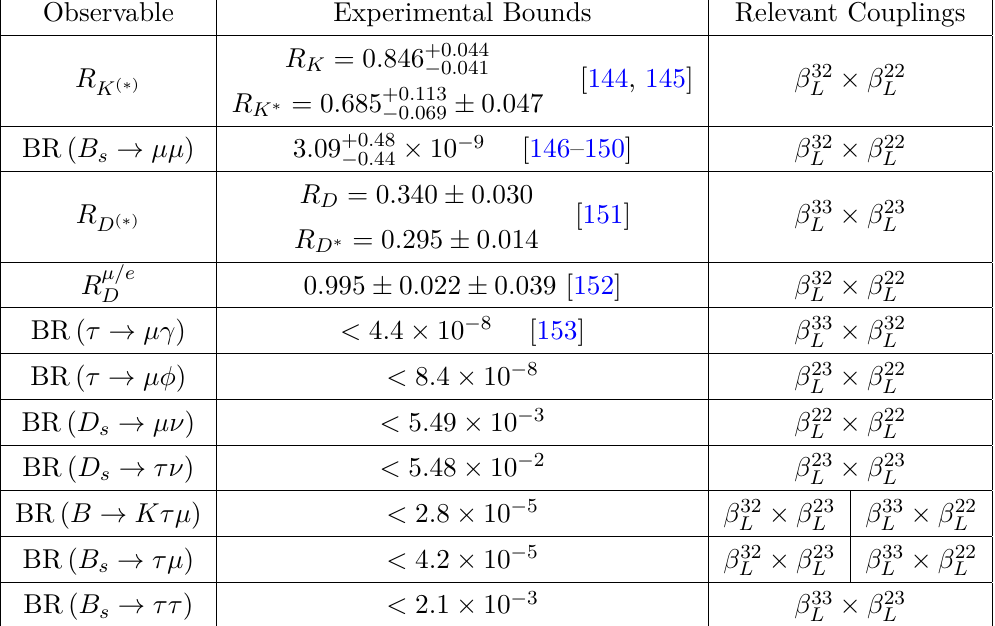
Table 2 . Various low-energy flavor observables along with the latest experimental result and the combination(s) of couplings relevant for each process at tree-level in the U 1 leptoquark model, based on the results of refs. [115, 154]. Experimental values are taken from ref. [155], unless otherwise noted.